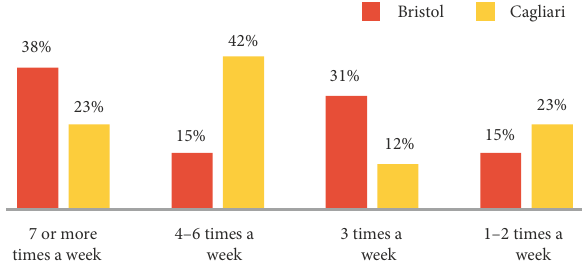
Figure 7. Delivery frequency in Bristol and in